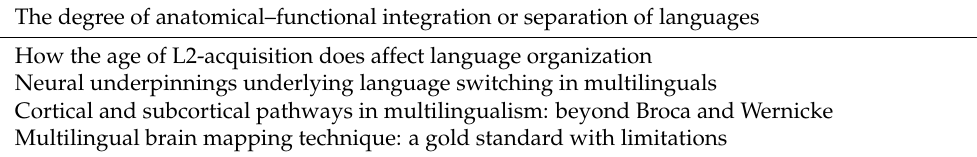
Table 1. Key questions about mapping in multilingual